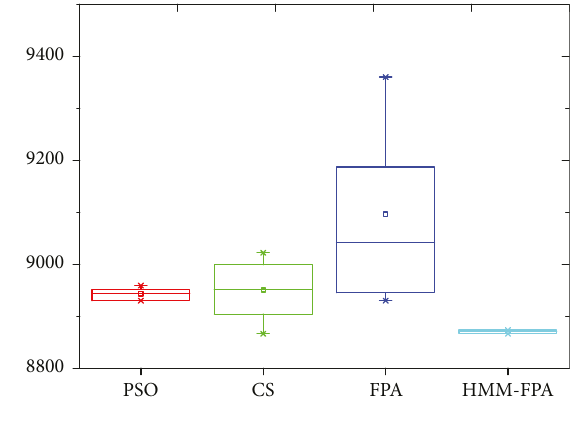
Figure 6: ANOVA tests of Car3.